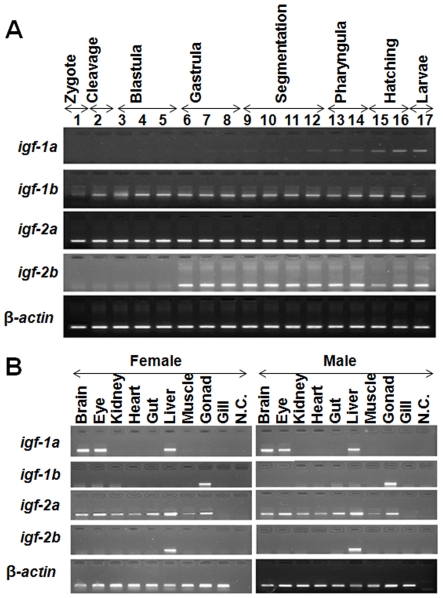
Temporal and spatial expression patterns of the duplicated zebrafish IGF genes.(A) RT-PCR analysis of IGF mRNAs in zebrafish embryos at the indicated stages. Numbers are the different embryo developmental stages (1, 1–2 cell; 2, 32-cell; 3, 512-cell; 4, oblong; 5, 30%-epiboly; 6, 50%-epiboly; 7, 90%-epiboly; 8, tailbud; 9, 2-somite; 10, 12-somite; 11, 18-somite; 12, 24–26 somite; 13, Prim-6; 14, Prim-22; 15, 48hpf; 16, 72hpf; 17, 96hpf). (B) RT-PCR analysis of IGF mRNAs in female and male adult zebrafish tissues.